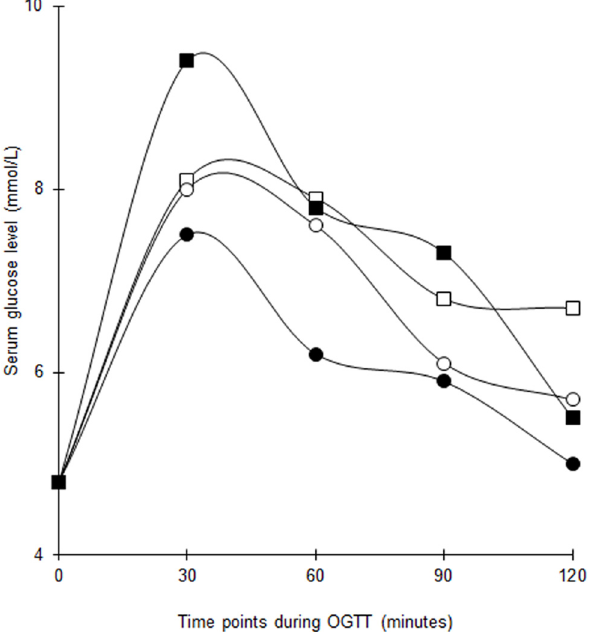
Fig 3. Changes in median serum glucose levels throughout 2-hour OGTT at baseline and post intervention among women with former GDM in both groups. White squares = Vitamin D group (baseline). Black squares = Vitamin D group (post intervention). White circles = Placebo group (baseline). Black circles = Placebo group (post intervention). The baseline differences of median serum glucose levels between vitamin D-supplemented group and placebo group at 0 (p = 0.817), 30 (p = 0.512), 60 (p = 0.383), 90 (p = 0.700) and 120 (p = 0.238) minutes were not statistically